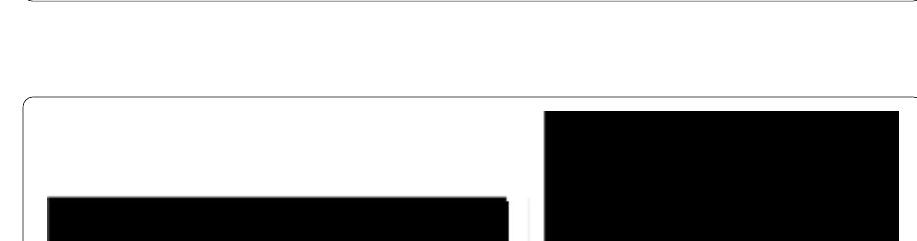
Fig. 4 Plate with a white background and b colored background